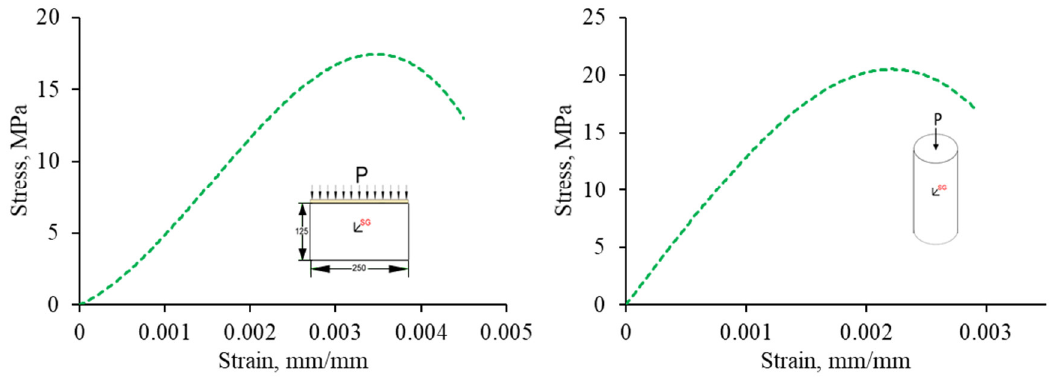
Figure 5. Multilinear stress-strain curve of RCIB ( left ) and concrete grout ( right ).